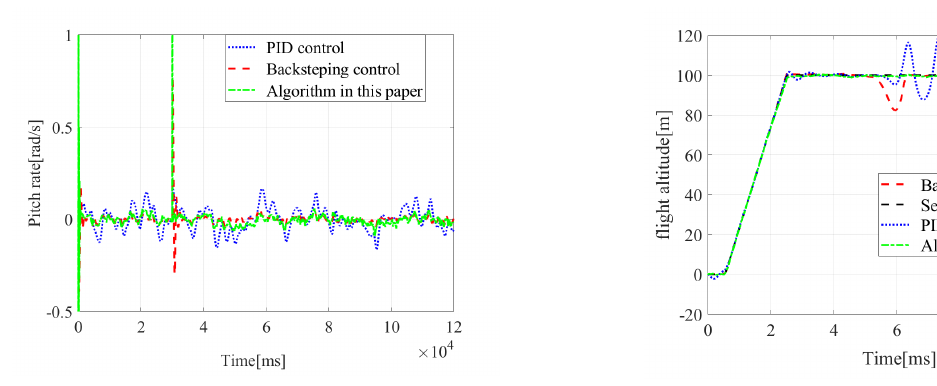
Fig. 6. Flight altitude curve in transition phase. decoupling control.